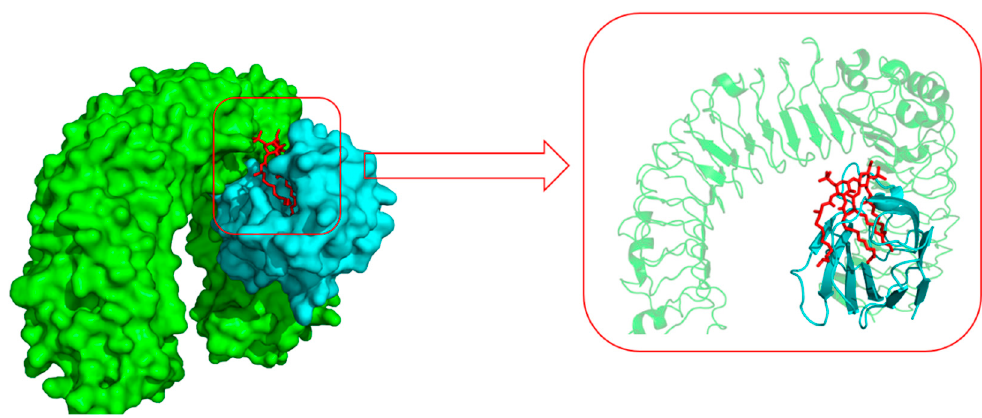
Figure 4. The surface representation of LPS (red) and Toll-like receptor 4 (TLR4) (green)/MD-2 (cyan) binding pocket (PDB: 3VQ2).